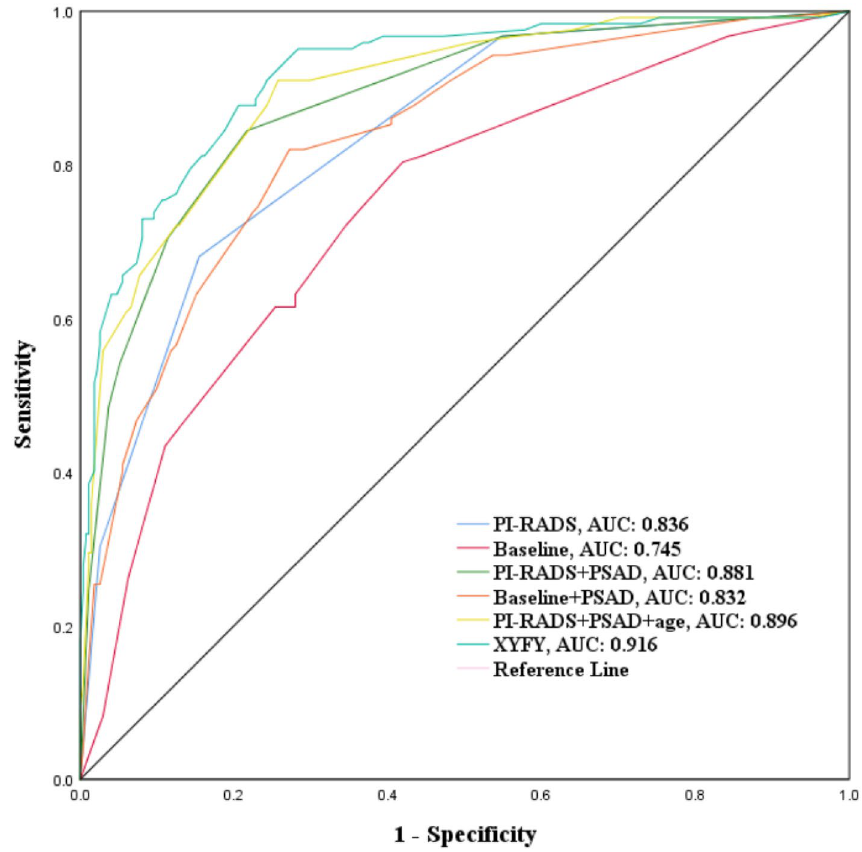
Figure 1. ROC curves comparing PI-RADS with PI-RADS + PSAD model, baseline model (baseline model was constructed on the basis of age, SII, and CysC level), baseline + PSAD model, PI-RADS + PSAD + age model, and XYFY model (XYFY model was constructed on the basis of age, SII, CysC level, PI-RADS v2.1 score, and PSAD) in predicting the outcomes of biopsy. ROC receiver operating characteristic; PI-RADS Prostate Imaging Reporting and Data System; PSAD prostate-specific antigen